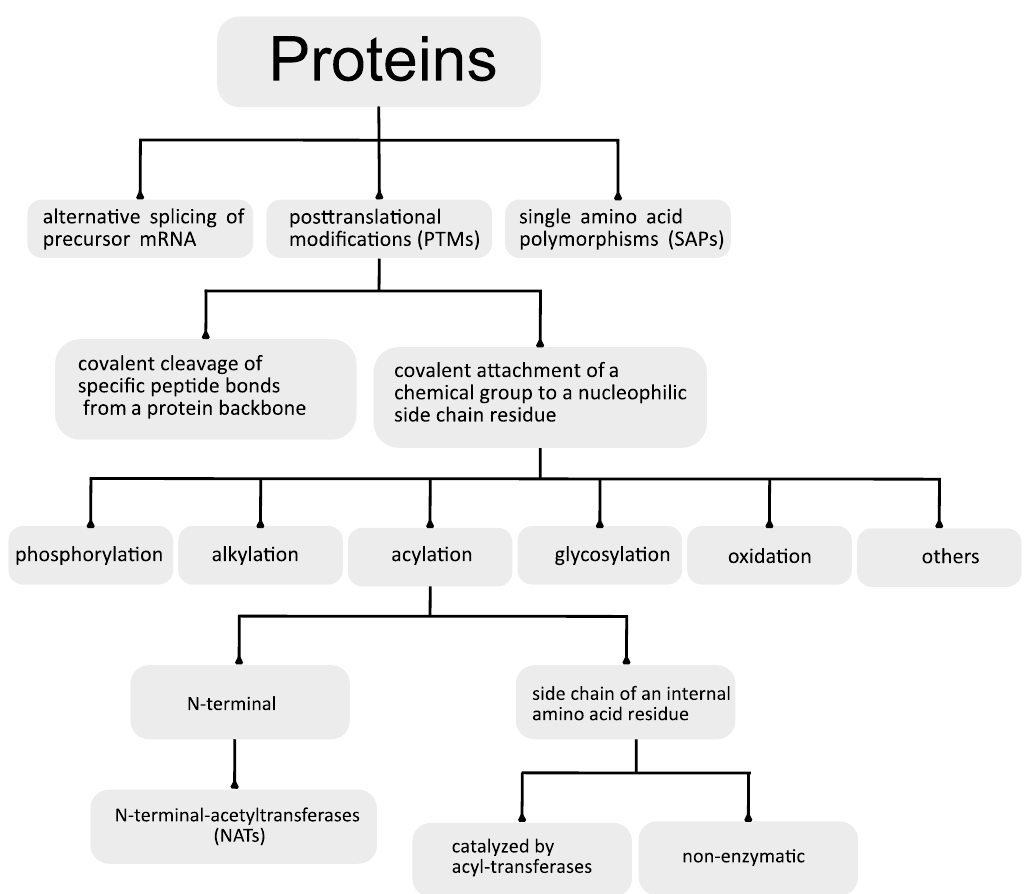
Figure 1. General overview of the cellular events related with the protein acylation process.